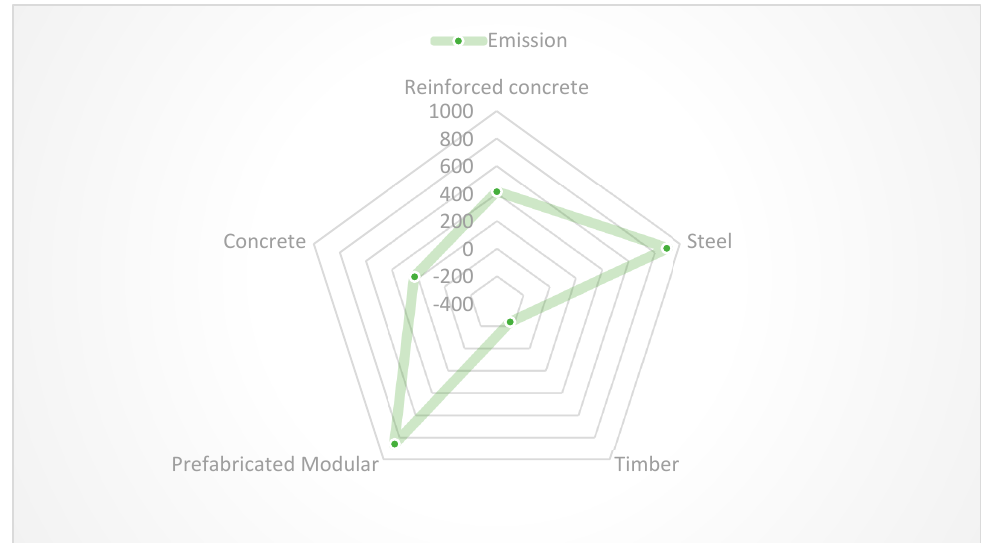
Figure 6. Comparison of emissions of high-rise residential buildings based on structure.